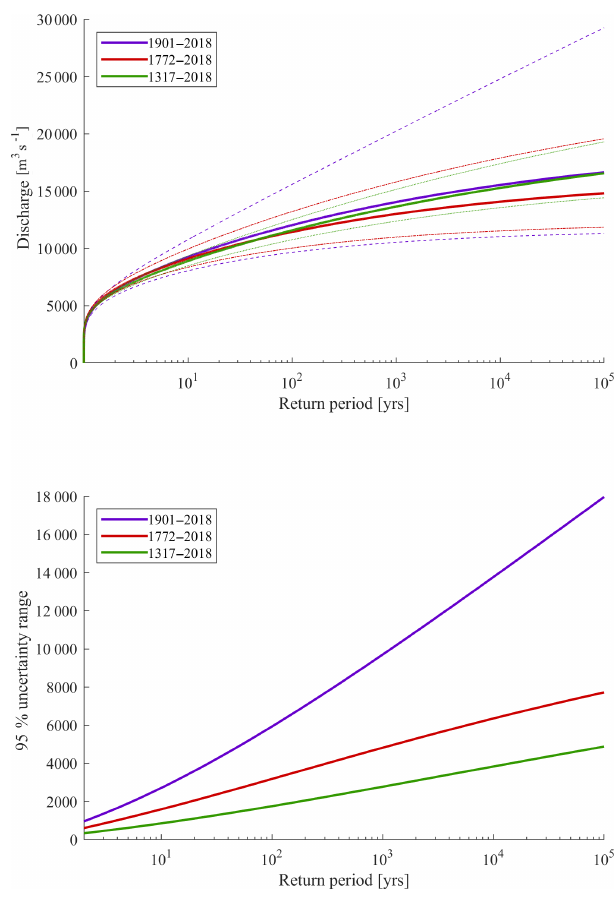
Figure 6. Fitted GEV curves and their 95% confidence intervals of the 1901, 1772, and 1317 data